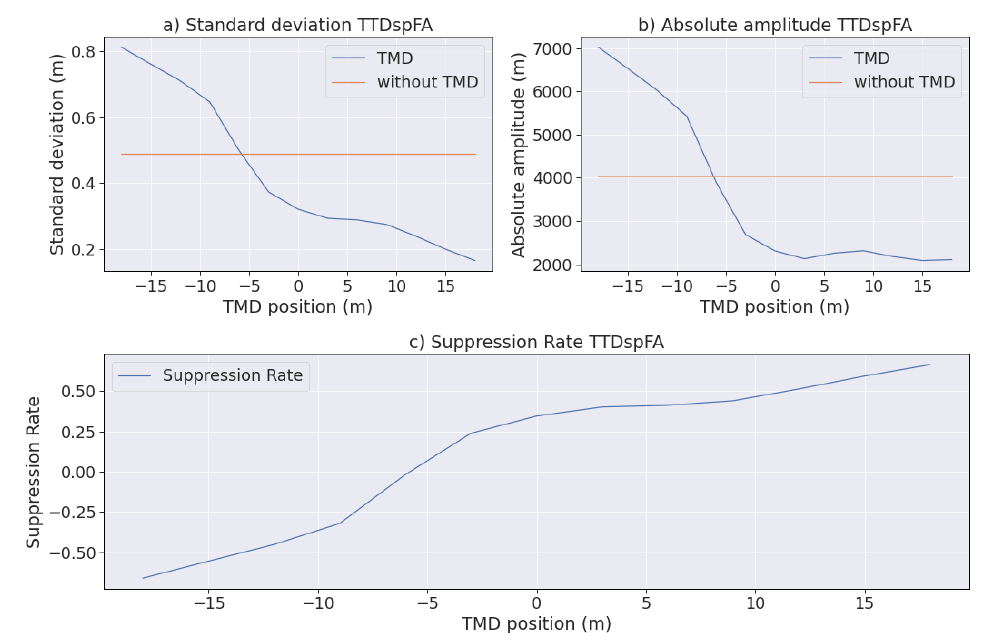
Figure 4. The results when moving the TMD along the fore-aft direction. ( a ) Sum of TTDspFA standard deviation; ( b ) Sum of TTDspFA amplitude; ( c ) TTDspFA suppression